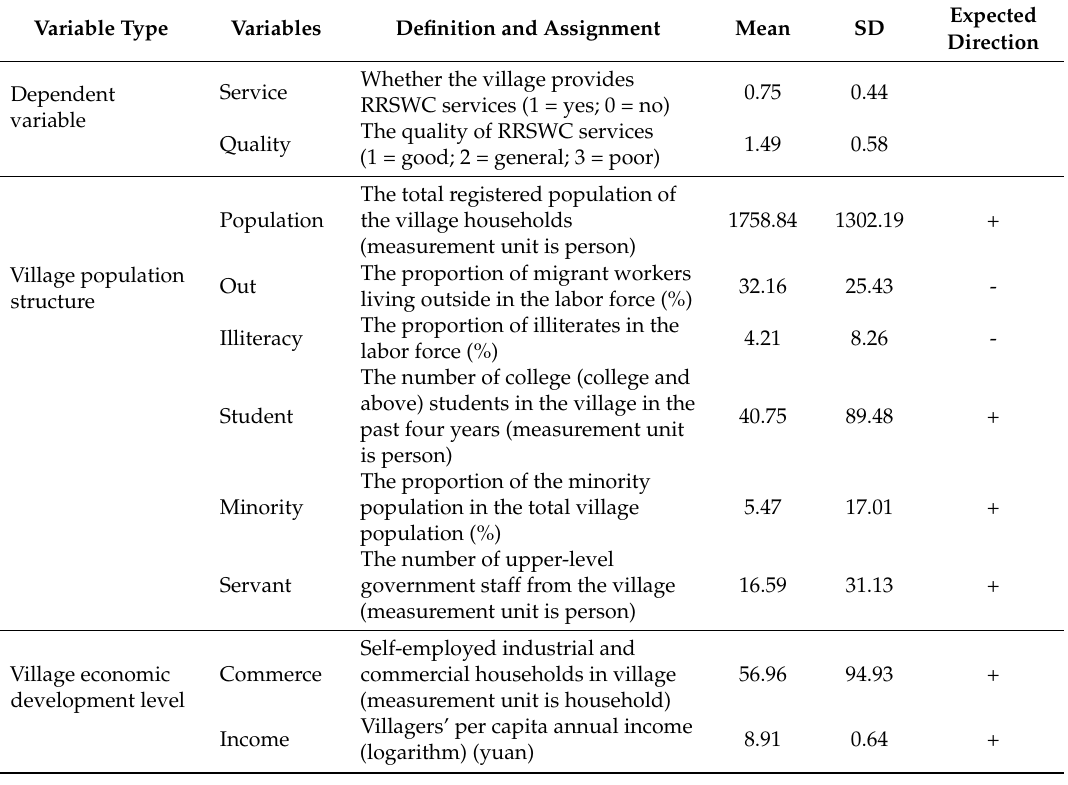
Table 2. The definition and data description of the final variables involving in the model 1